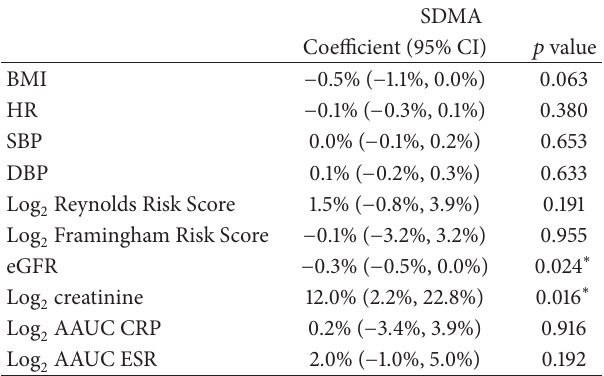
Table 2: Univariable analysis of continuous factors. Table 3: Univariable analysis of categorical